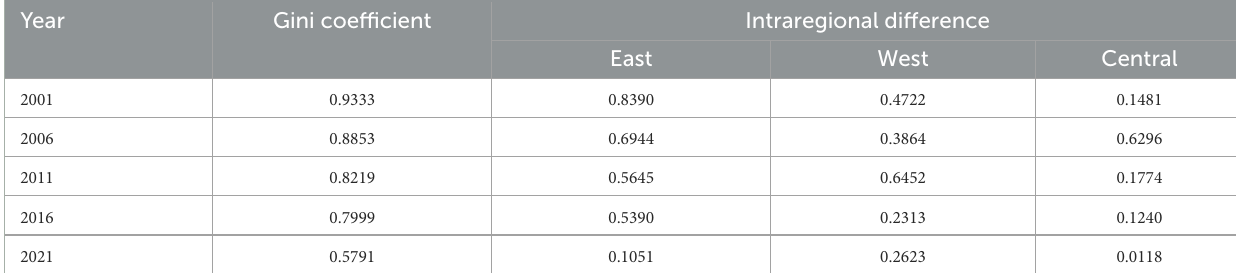
TABLE 2 The Gini coefficients of low-carbon patent applications nationwide and in the eastern, central, and western